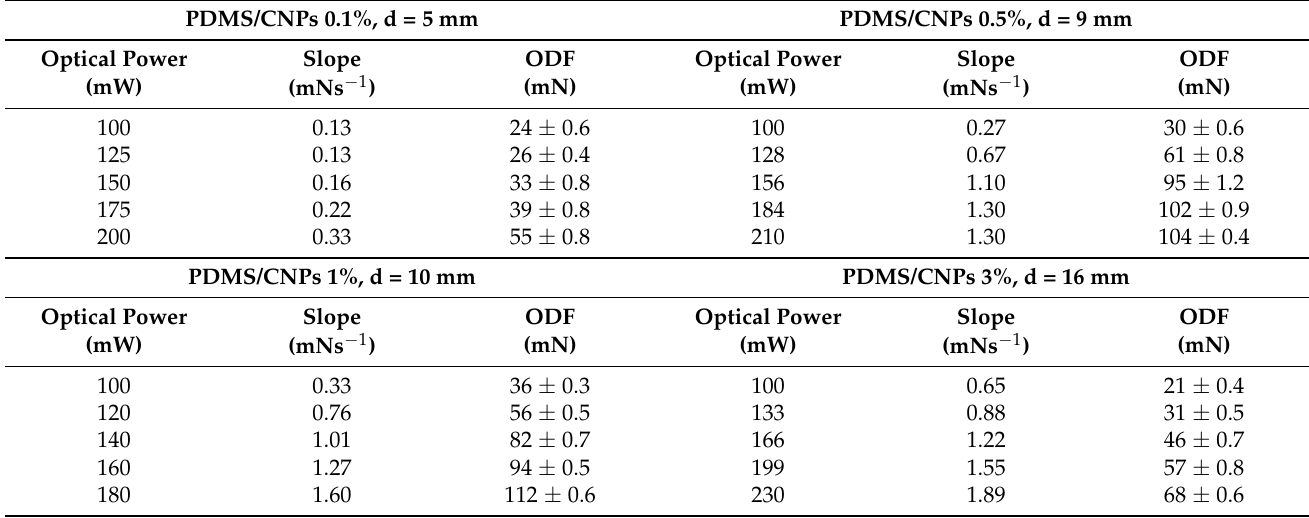
Table 2. Optically driven forces (ODFs) and velocities of actuation of the nanocomposites under NIR irradiation located at first times (linear trend regions).